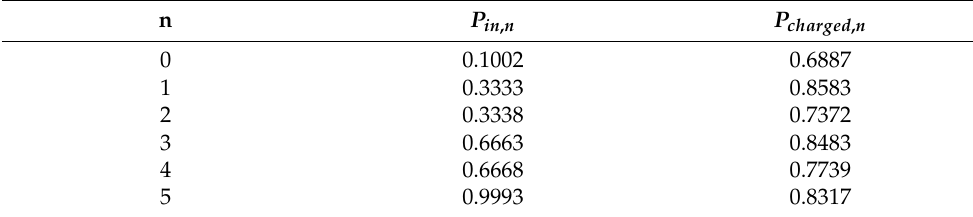
Table 8. Breakpoint values for the analyzed charging process of the PHES. n P in ,